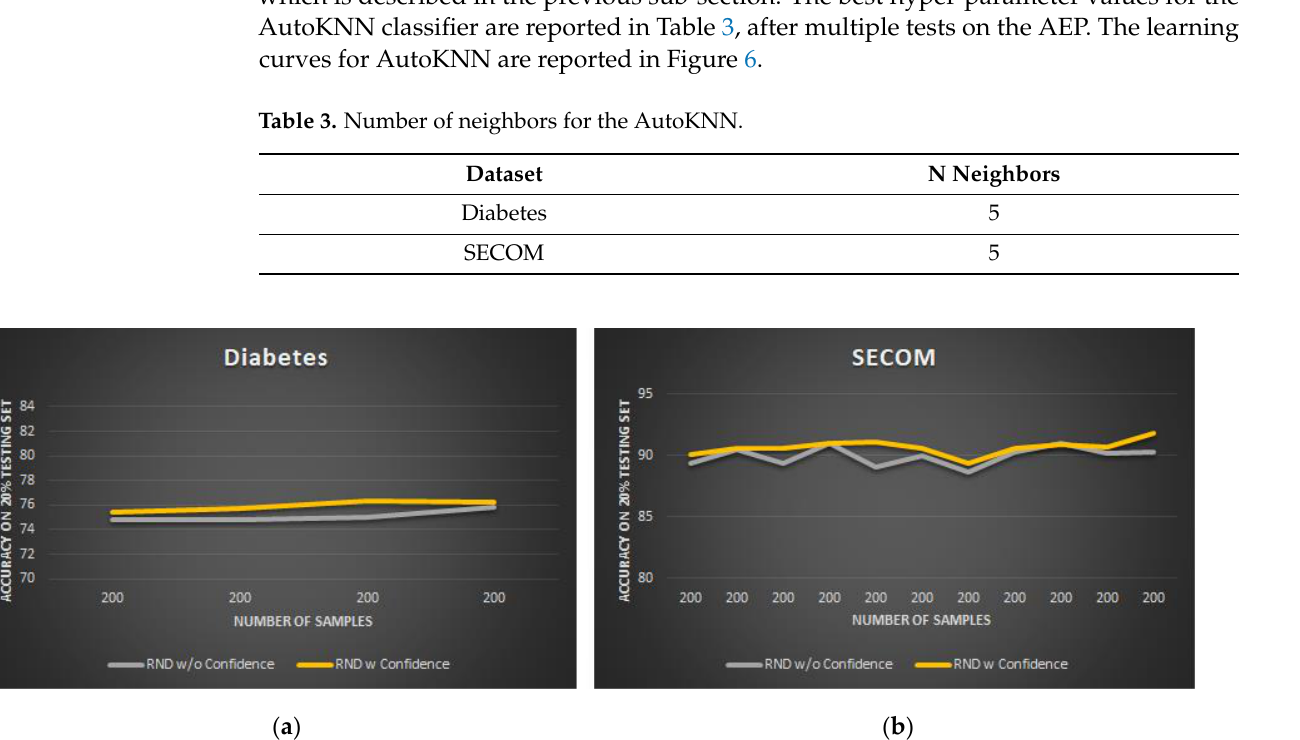
Figure 6. Learning Curves of AutoKNN on ( a ) Diabetes and ( b ) SECOM datasets.